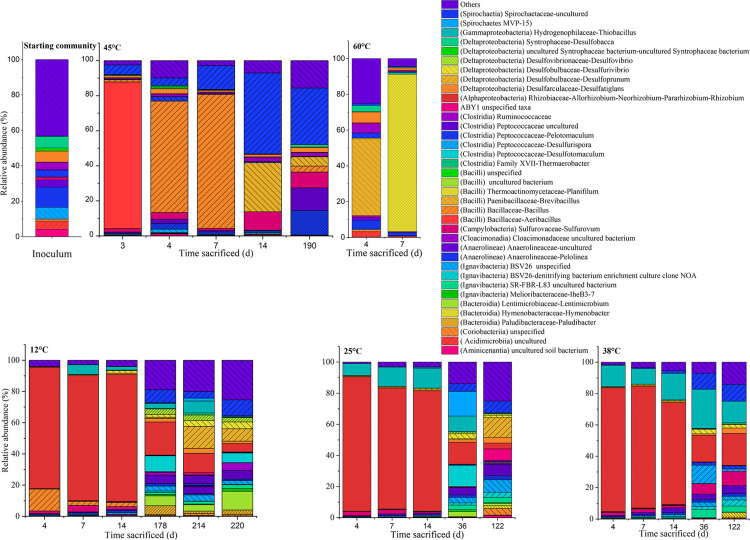
Time-resolved distribution of the bacterial community composition assigned to genera. Members which constitute < 3.0% across all samples were grouped as others (<3.0%). The class assignments of the respective genus assigned within the parentheses.